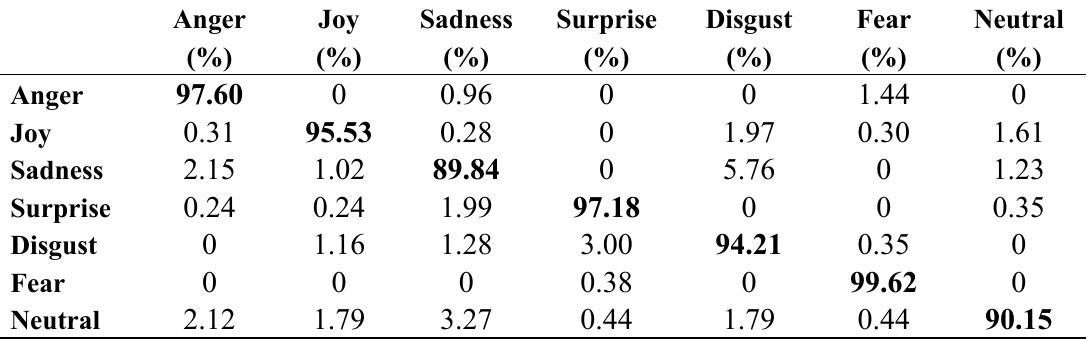
Table 4. Confusion matrix of 7-class facial expression recognition results obtained by KDIsomap on the Cohn-Kanade